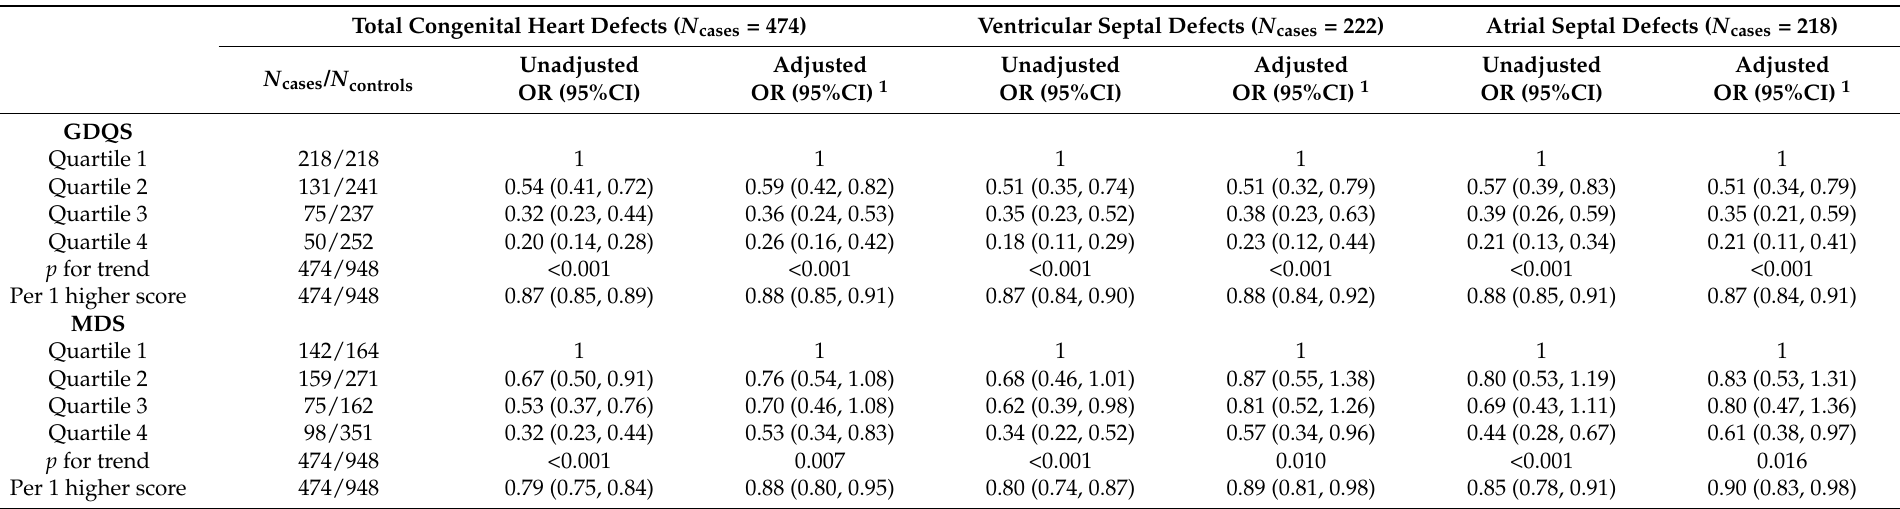
Table 3. Associations of maternal GDQS and MDS during pregnancy with congenital heart defects. Total Congenital Heart Defects ( N cases =